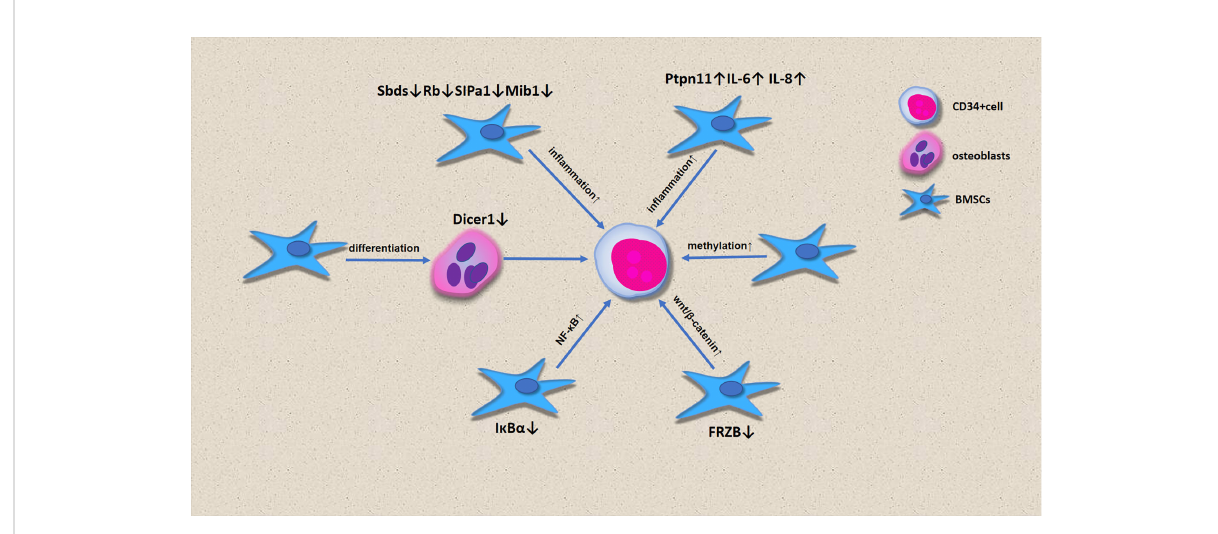
FIGURE 3 The role of MSC in the onset of